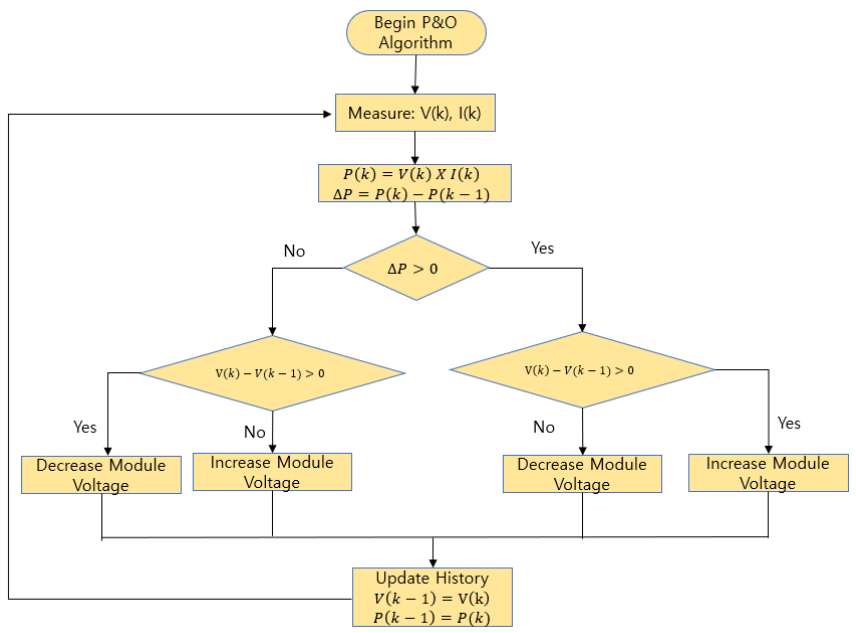
Figure 3. Perturbation and observation-based maximum power point tracking (MPPT).